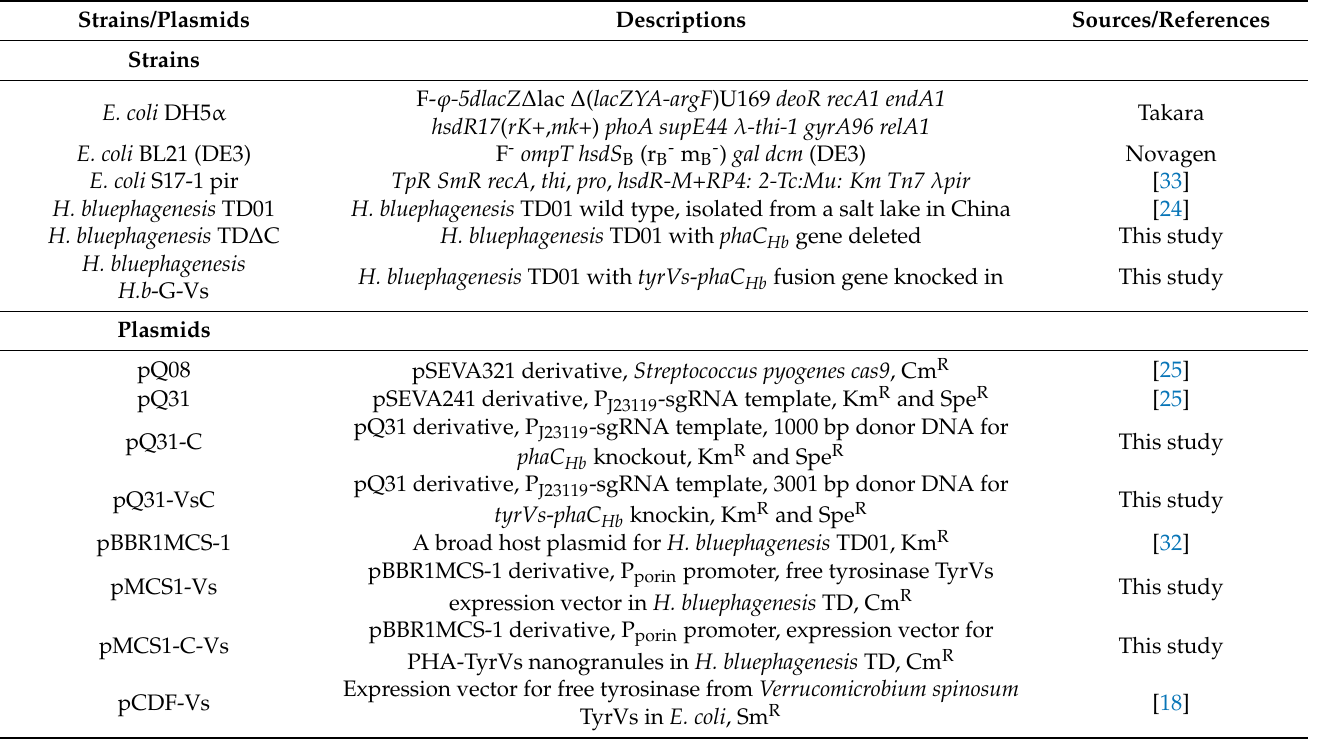
Table 2. Plasmids and bacterial strains used in this